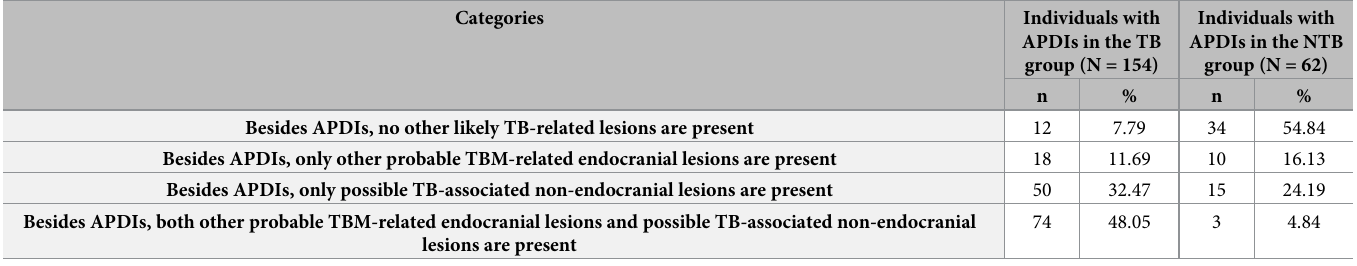
Table 5. Summary of the statistical results, considering the co-occurrence of APDIs with other likely TB-related lesion